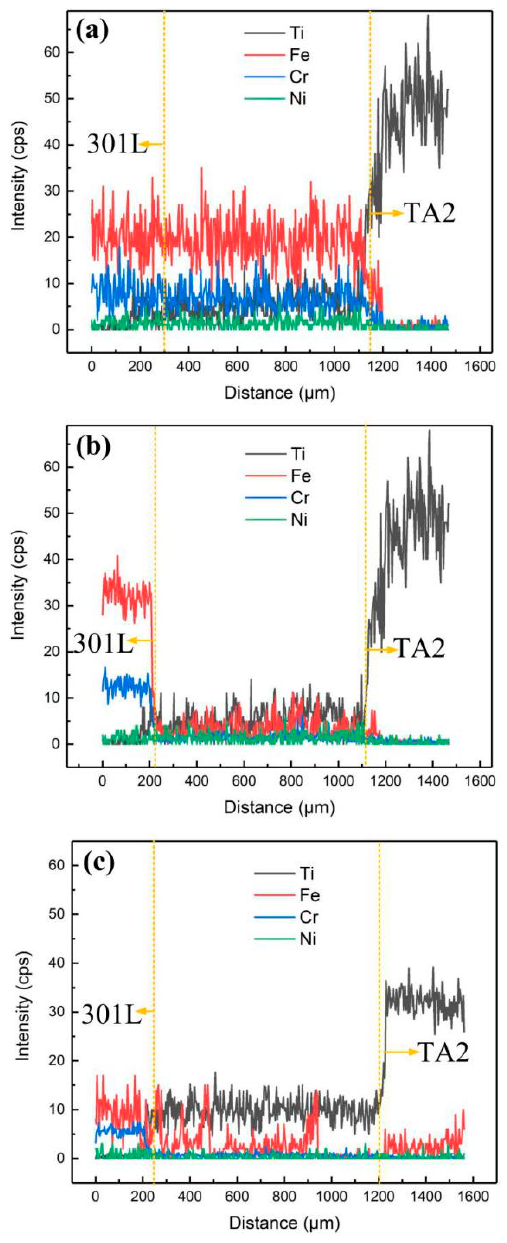
Figure 5. The cross-sectional line scanning results of 301L/TA2 welded joints with different laser offsets: ( a ) Path 1 with offset of − 0.3 mm; ( b ) Path 2 with offset of 0 mm; ( c ) Path 3 with offset of +0.3 mm.